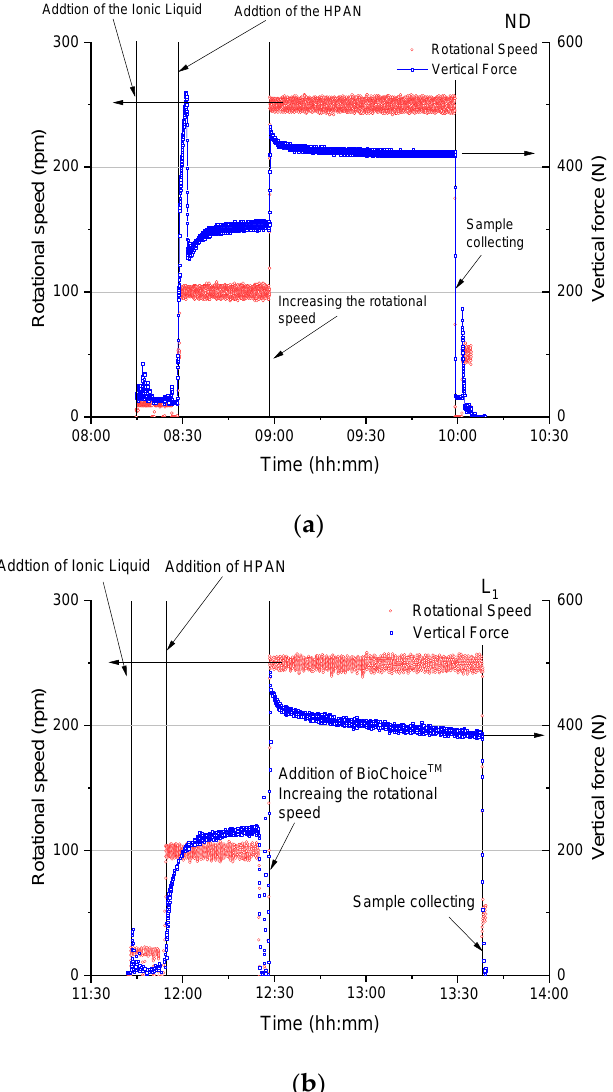
Figure 1. Compounding procedure, rotational speed and dwell time of the ( a ) PAN/IL dopes (ND) and ( b ) PAN/lignin/IL (PAN/lignin = 2:1) (L1) and the impact of the added lignin on the vertical force of the compounding screws. HPAN, homo-polyacrylonitrile.